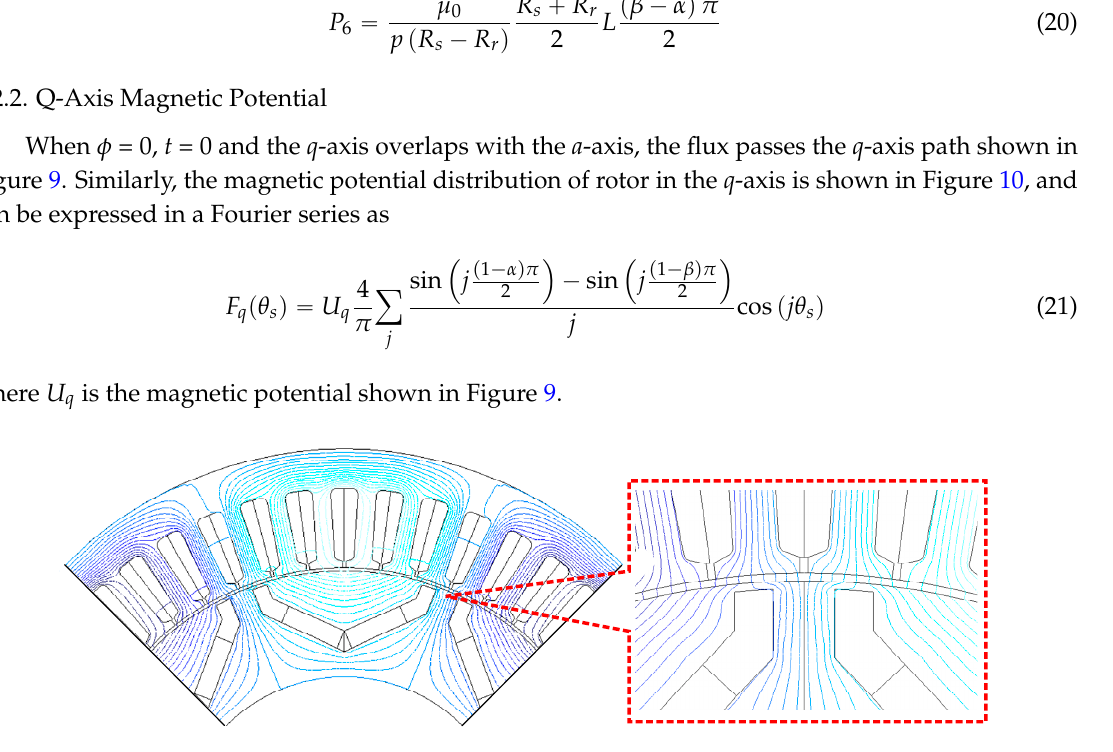
Figure 9. Flux line distribution in the q ‐ axis.